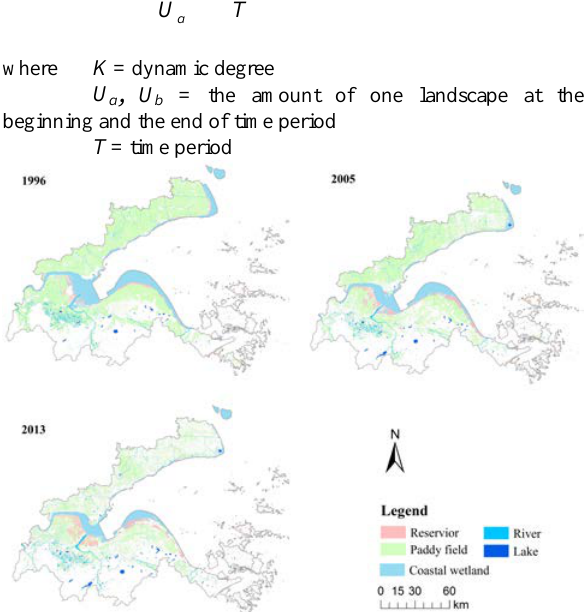
Figure 2. Distribution of wetlands in the Hangzhou Bay in 1996, 2005 and